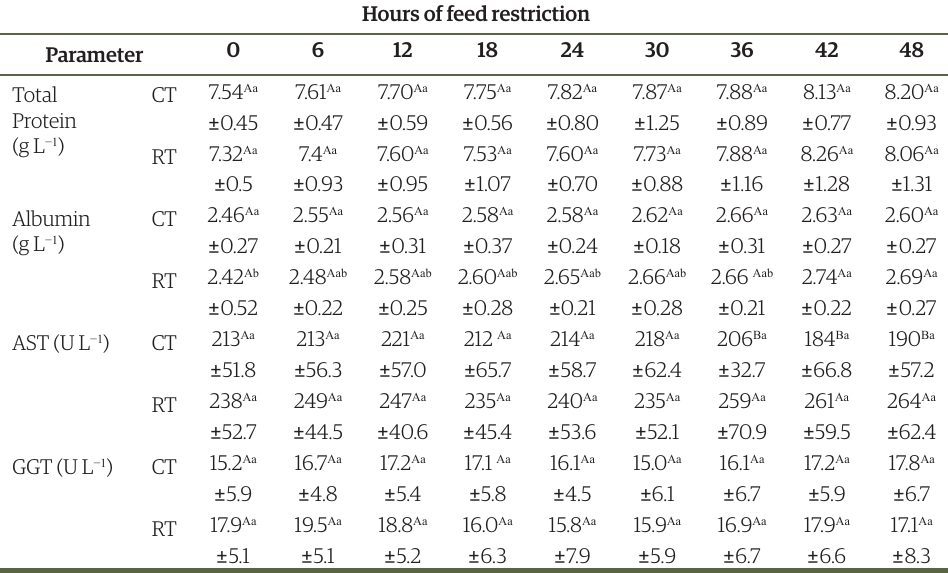
SD of total protein, albumin, aspartate transaminase (AST) and gamma glutamyl transferase Table 5. Mean concentrations in horses during feed restriction (RT) for 48 h and in control horses ±